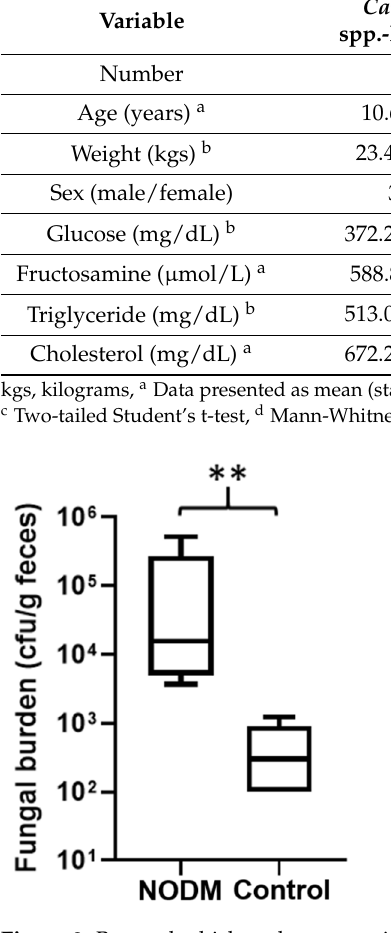
Figure 2. Box and whisker plot comparing quantitative fungi growth from fecal cultures in dogs with naturally occurring diabetes mellitus ( n = 5) and non-diabetic healthy controls ( n = 6). The top and bottom of the boxes represent the 75th and 25th quartiles, respectively with the black horizontal line representing the median. The whiskers represent the range of data. ** p = 0.004.